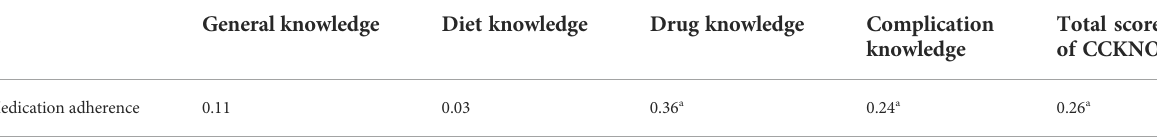
TABLE 5 Correlation between medication adherence and parental CCKNOW scores of children with IBD ( n = 119).